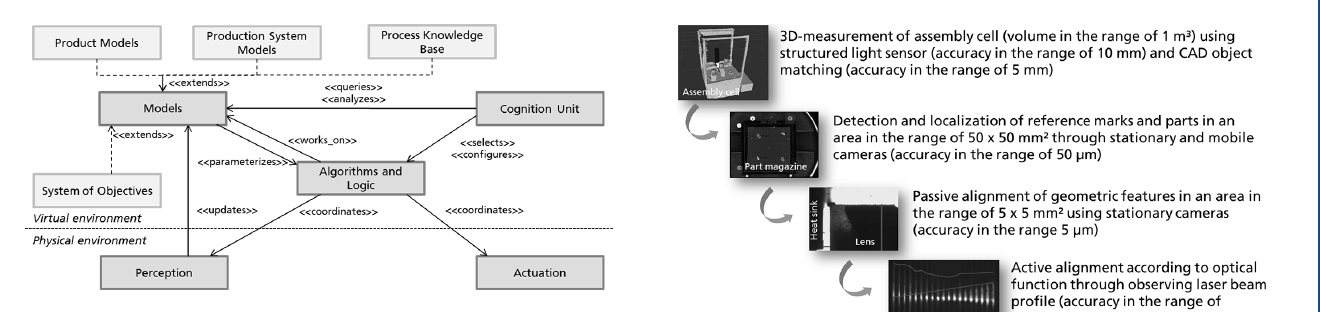
Figure 1. Reduced ontology of a self-optimizing assembly system.